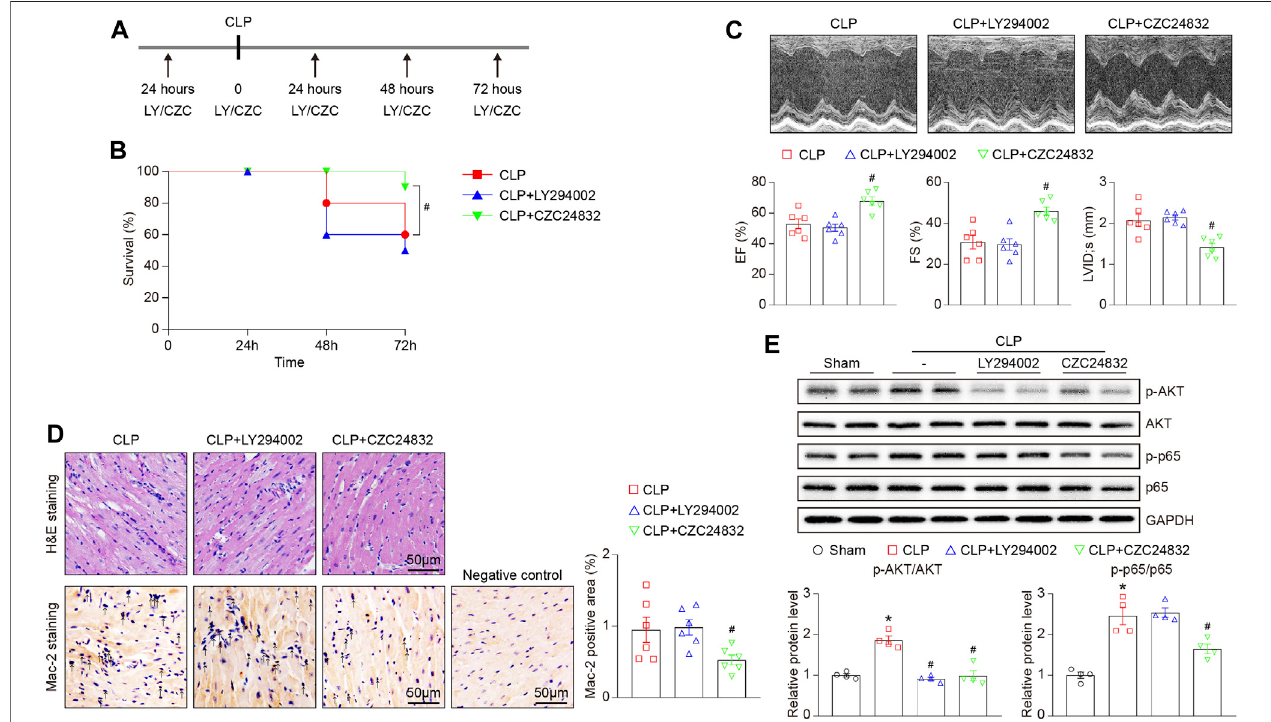
FIGURE 7 | Effects of LY294002 and CZC24832 on CLP-induced septic cardiomyopathy. Mice were pretreated with LY294002 and CZC24832, and then subjected to CLP for 72 h. (A) Schematic diagram of the experimental design. (B) Kaplan – Meier survival analysis (n = 10 per group). (C) Representative M-mode echocardiographicimagesofleftventricularat72 hafterCLPsurgery(top).Quanti fi cationofEF%,FS%,andLVID;s(bottom,n=6pergroup). (D) Representativeimages of H&E staining (top) and Mac-2 immunohistochemical staining (bottom) of heart sections. Arrows indicate the Mac-2 – positive cells. Scale bar: 50 μ m. Quanti fi cation of Mac-2 – positive cells (right, n = 6 per group). (E) Immunoblotting analysis of the protein levels of p-AKT, AKT, p-p65, and p65 in the heart tissues (top). Quanti fi cation of the relative protein levels (bottom, n = 4). GAPDH as an internal control. After the normality test (Shapiro – Wilk), the student t-test was used to compare thesigni fi cantdifferencebetweentwogroupsinnormaldistribution,andtheMann – Whitneytestwasperformedforthedatathatwerenotnormallydistributed.* p < 0.05 versus sham control, # p < 0.05 versus CLP.